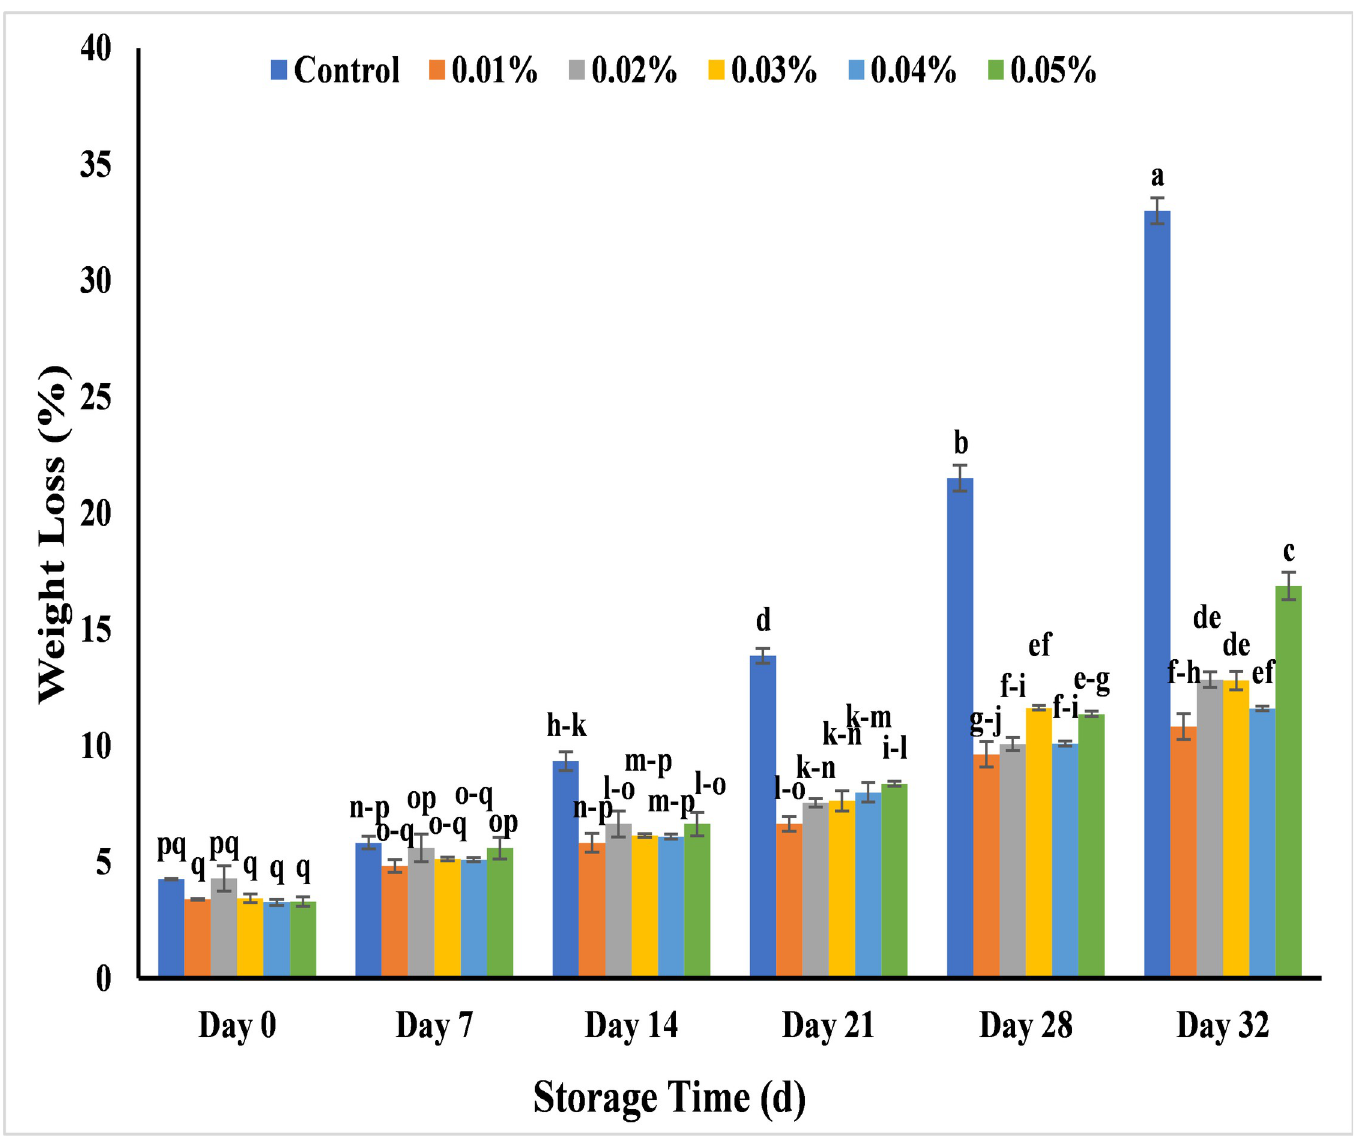
Fig 13. Effect of AgNPs concentrations (T0 = control, T1 = 0.01%, T2 = 0.02%, T3 = 0.03%, T4 = 0.04%, T5 = 0.05%) on weight loss percentage of Cavendish banana (BASRAI) during 32 days of storage.